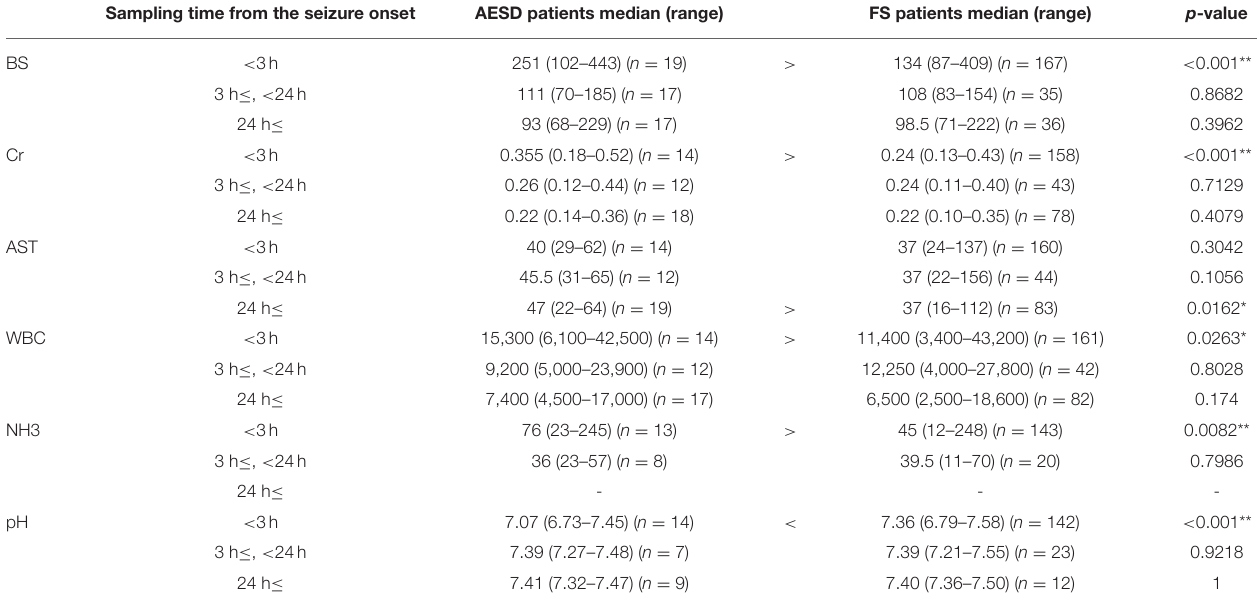
TABLE 4 | The differences of values between AESD and FS patients at each period of sampling time. Sampling time from the seizure onset AESD patients median (range) FS patients median (range)